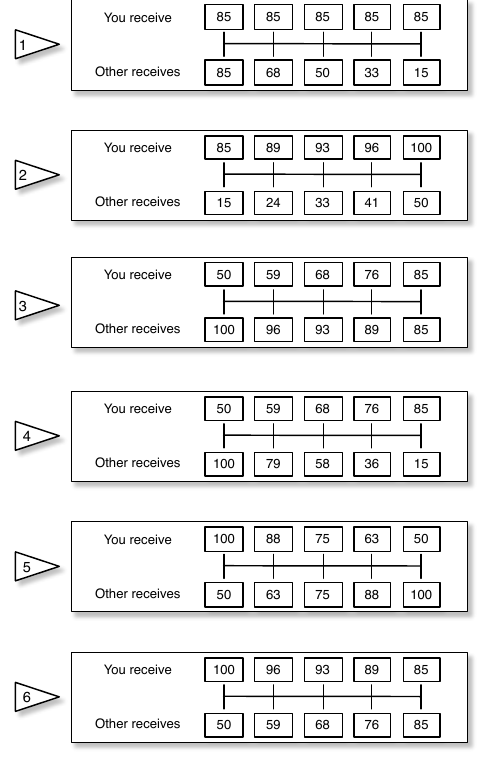
Figure A1. The six resource allocation tasks from the SVO Slider